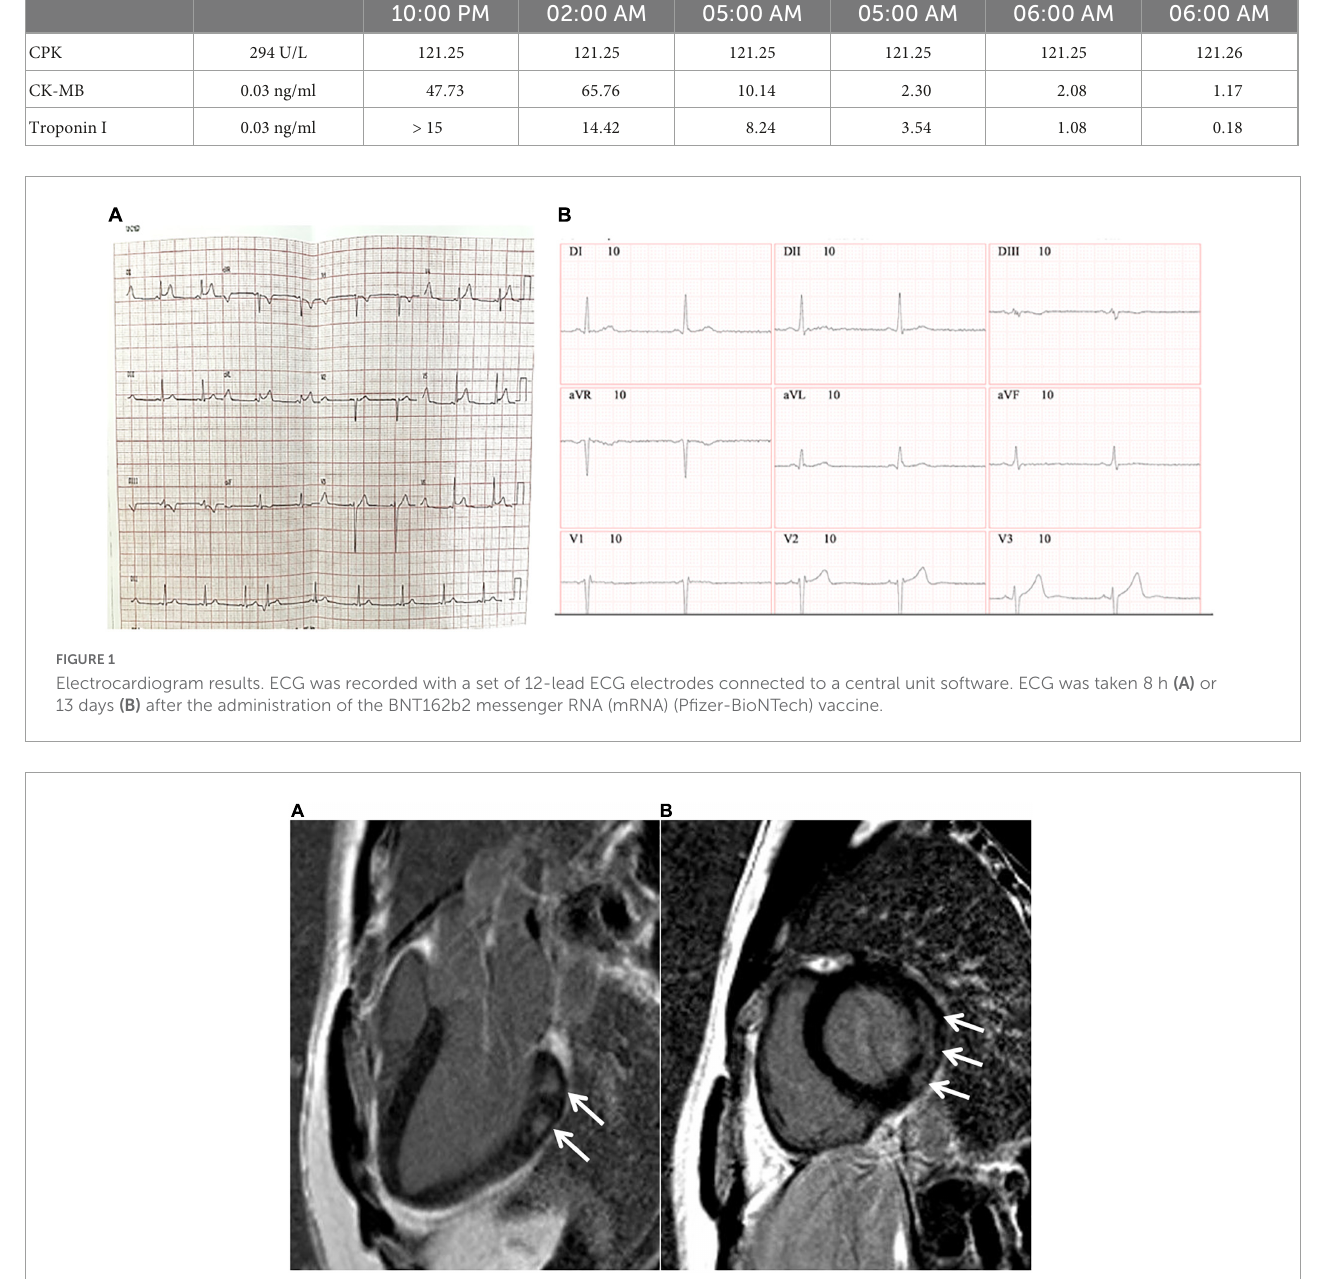
FIGURE2 MRI results. Cardiac MRI 16 days after the administration of the BNT162b2 messenger RNA (mRNA) (Pfizer-BioNTech) vaccine, 1.5-T MR system. Delayed enhancement sequence in the long axis (A) and short axis (B) . Arrows indicate an area of myocardial fibrosis with a non-ischemic pattern in the basal lateral wall, compatible with